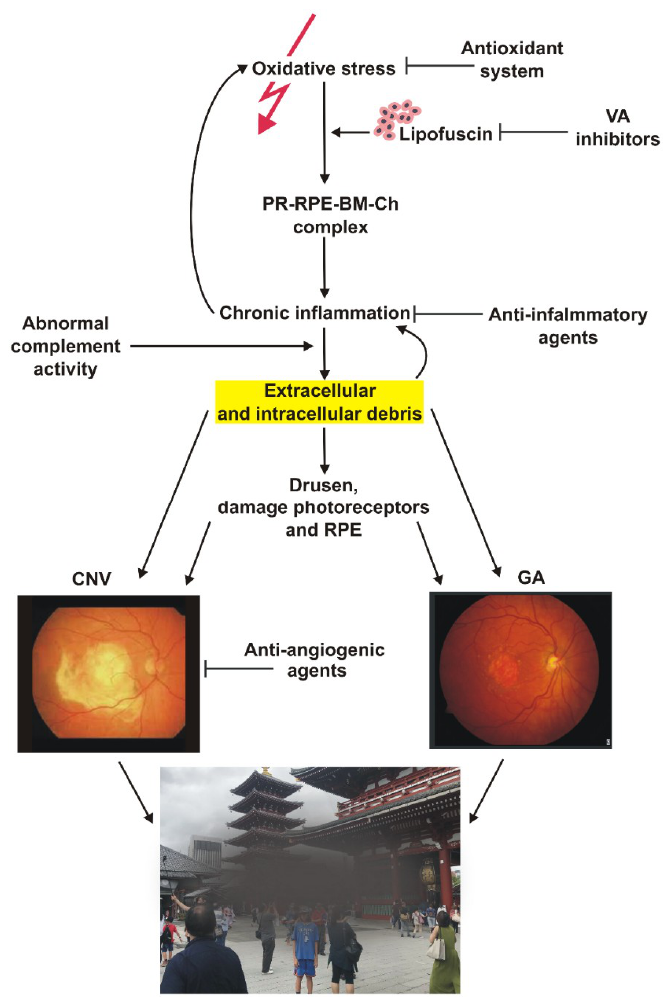
Figure 1. Schematic representation of the pathogenesis of age-related macular degeneration (AMD) with an important role of cellular waste (yellow highlight). Oxidative stress (red thunder) can be generated by many environmental/life style risk factors as well as yet unidentified sources. Visual cycle (VA) by-products can contribute to cellular waste. A complex interplay between oxidative stress, chronic inflammation, variants of genes encoding the complement and cellular waste clearing may lead to degeneration of retinal cells and clinically detectable AMD, which in its advanced stage may acquire the form of geographic atrophy (GA) or wet AMD, characterized by choroidal neovascularization (CNV). AMD symptoms include loss of central vision. Sharp black arrows indicate stimulation/consequences, whereas blunt black arrows—inhibition. PR—photoreceptors, RPE—retinal pigment epithelium, BM—Bruch’s membrane, Ch—choriocapillaris.